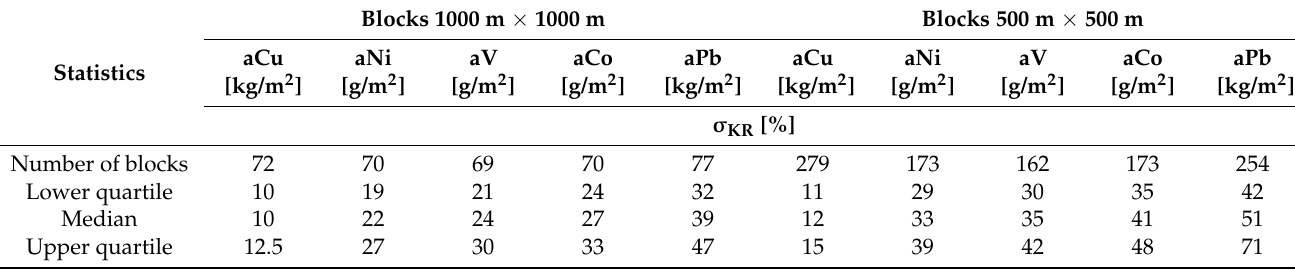
Table 6. Quartiles of relative standard kriging errors of estimates ( σ KR [%]) of the average Cu abundance and resources and the accompanying elements in blocks with areas 0.25 and 1.0 km 2